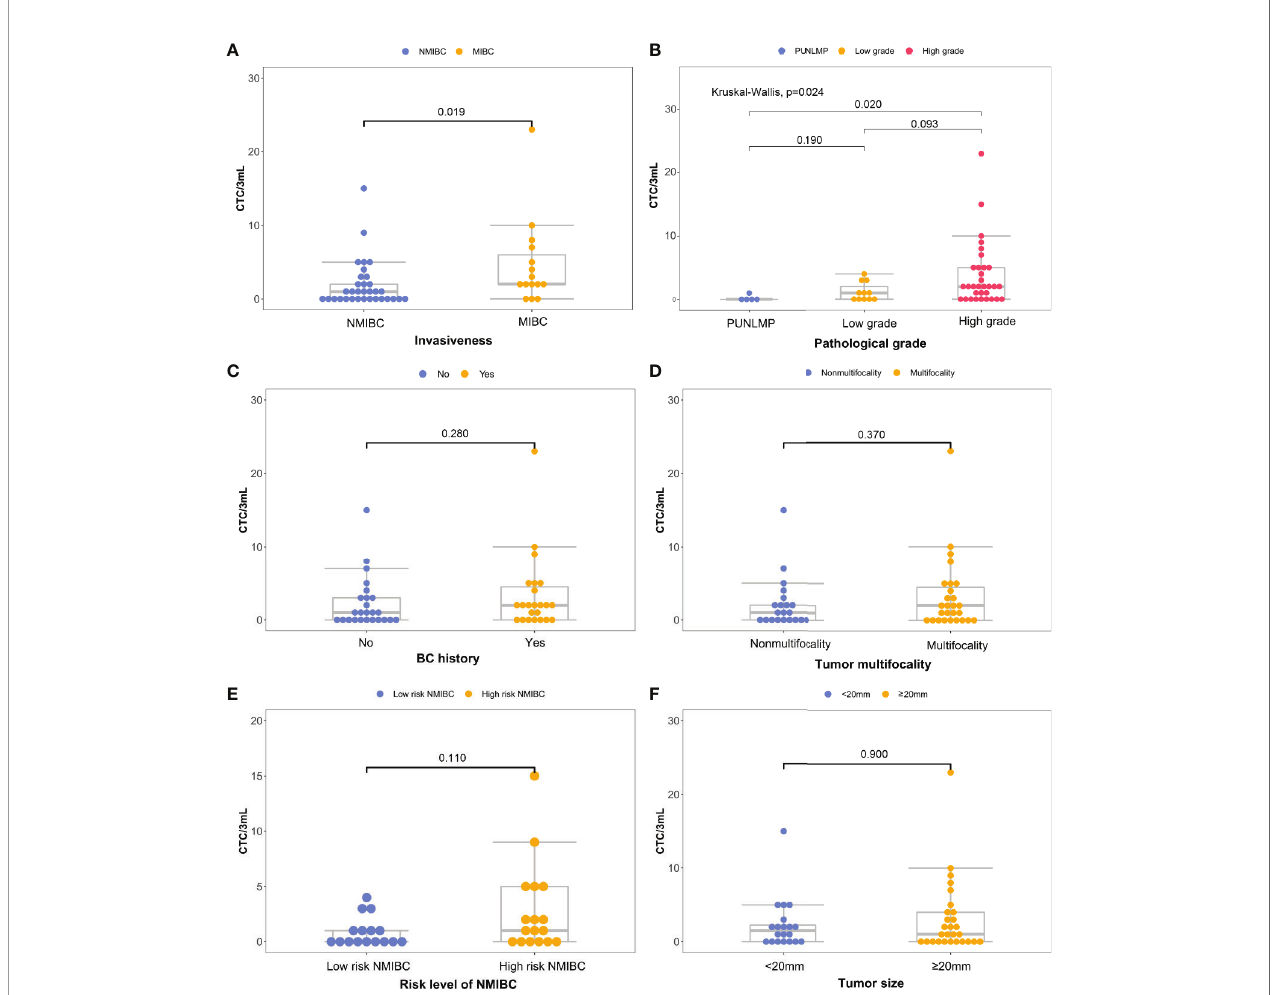
FIGURE 4 | Correlations between CTC count and primary clinical outcomes: (A) histological grade, (B) invasiveness, (C) previous bladder cancer history, (D) multifocality, (E) progression risks of the NMIBC, (F) tumor